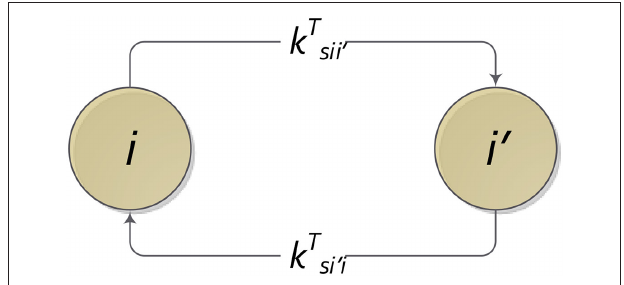
FIGURE 1 | Schematic representation of the super-structure for a compartmental